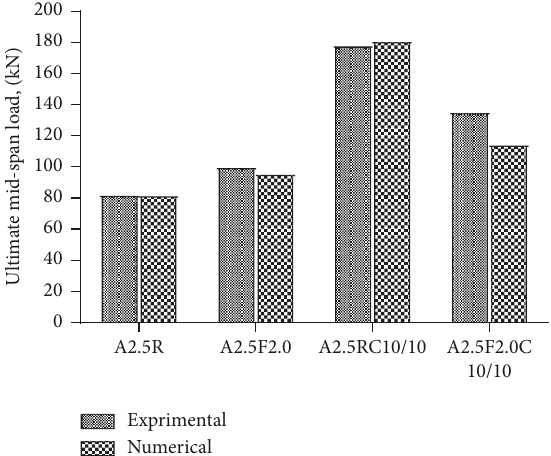
Figure 9: Comparison between ultimate experimental and ultimate numerical midspan load for all beams.